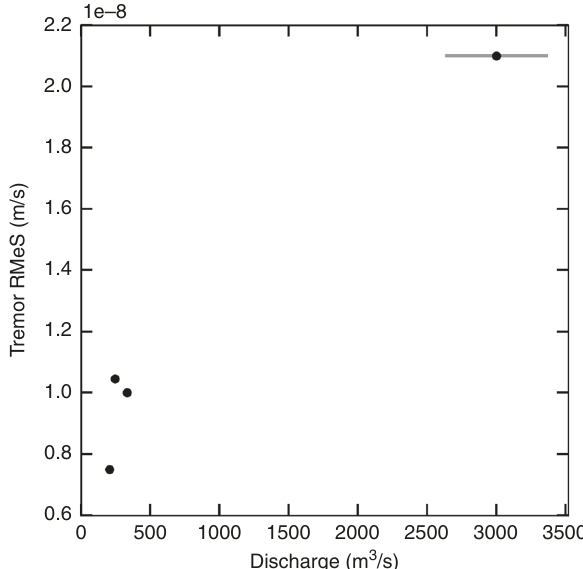
Fig. 7 Peak discharge and Type 1 tremor amplitude correlate. Peak discharge during fl oods from the Skaftá cauldrons in comparison to peak Root Median Square (RMeS) tremor amplitude during the subglacial propagation of the fl ood front from the lake to the ice terminus (Type 1 tremor). Contamination of the peak amplitude by short transients such as earthquakes is avoided by calculating RMeS instead of Root Mean Square of the seismic waveform and by focussing on the time window where Type 1 tremor is present. Error bars on discharge values below 1000m 3 /s and tremor are smaller than the symbol used. Uncertainty for higher discharge values was estimated from the combined uncertainty of the discharge measurements at Sveinstindur and the uncertainty on the estimate of discharge that bypasses the hydrometric station 52